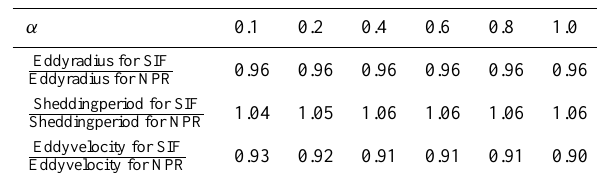
Table 1. Theoretically estimated (Concave I) shedding ratios as a function of the vorticity coefficient, α